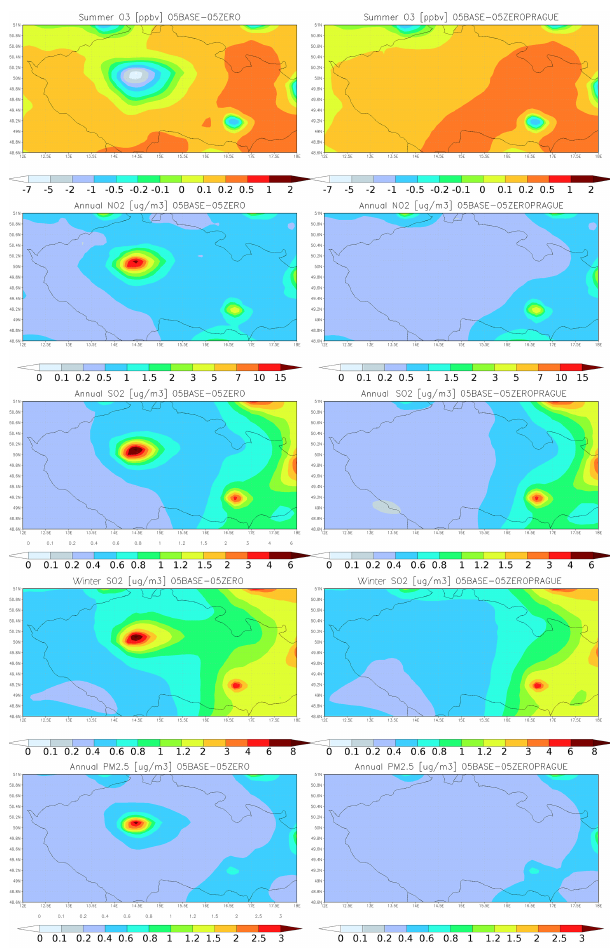
Figure 10. Impact of city emissions on average O 3 (ppbv; summer), NO 2 (µgm − 3 ; annual), SO 2 (µgm − 3 ; annual and DJF) and PM 2 . 5 (µgm − 3 ; annual). Left column: impact of all cities, right column: impact off all cities except